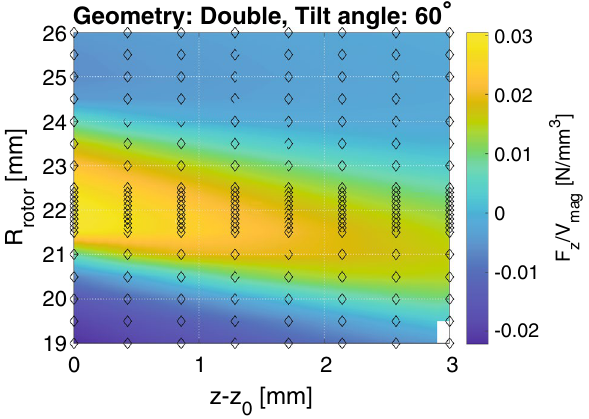
Figure 3. A surface map of the volume normalized force, F z / V mag , as function of the radius of the rotor and the relative z -displacement for the bearing with a double geometry and a tilt angle of 60 ◦ . The diamonds show the data points used to interpolate the surface. Note that z − z 0 is a function of R rotor and thus the absolute z − position of the rotor increase as the rotor radius increases. At high values of R rotor the rotor is entirely above the